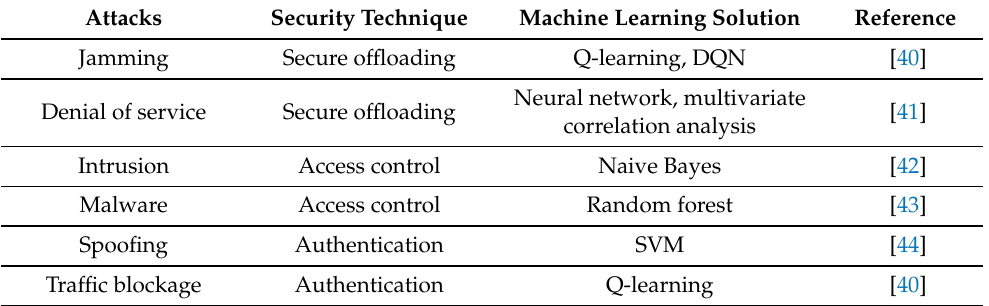
Table 3. Data security for intelligent